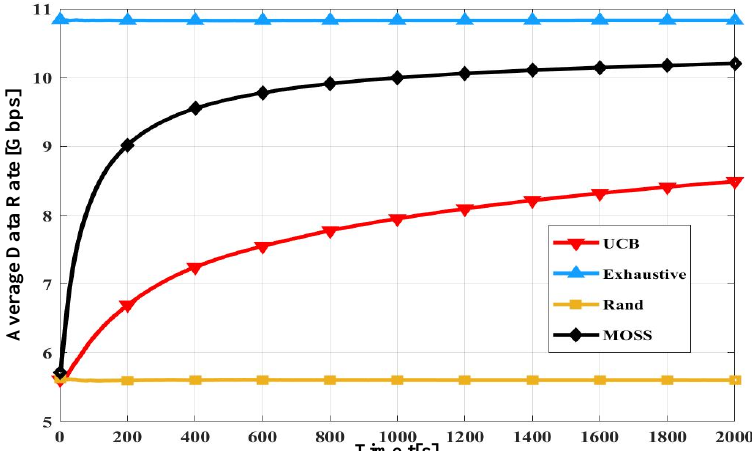
Figure 7. Upper confidence bound (UCB) and minimax optimal stochastic strategy (MOSS) conver- gence vs.